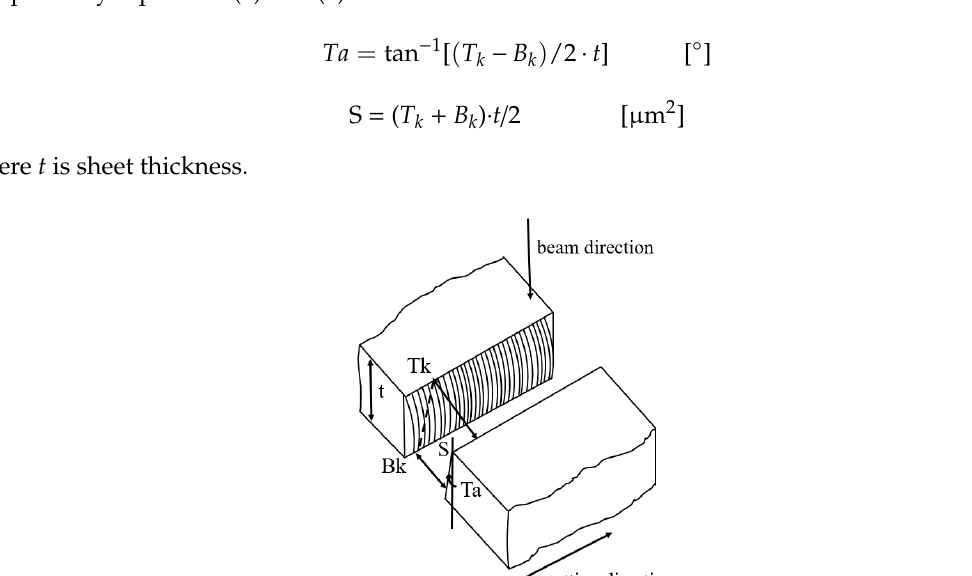
Figure 4. Schematic of profile acquisition.